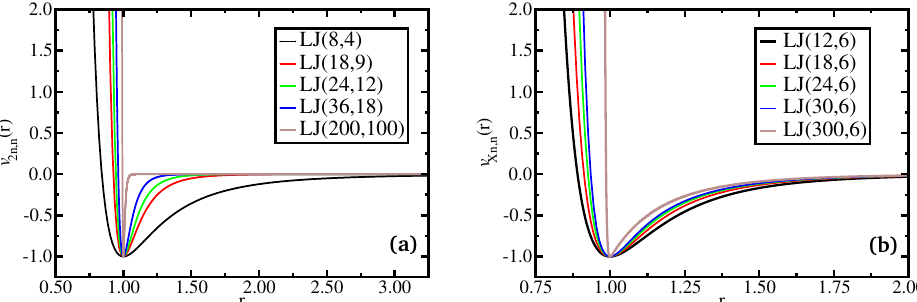
Figure 1: Different generalized LJ ( m (cid:48) , n (cid:48) ) pair potentials. (a) m (cid:48) = 2 n (cid:48) for several choices of the value of n (cid:48) = 4,9,12,18,100. Upon increasing n (cid:48) the potential be-